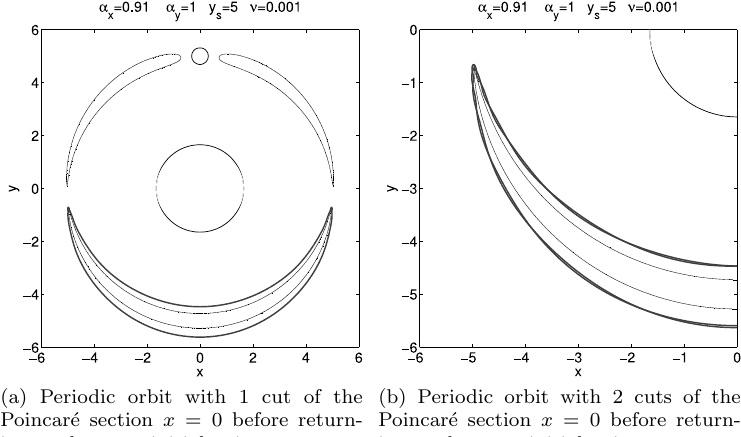
Fig. 9. Some stable symmetric periodic orbits with C = (cid:0) 0 . 30011 for the shape parameters α x = 0 . 91, α y =